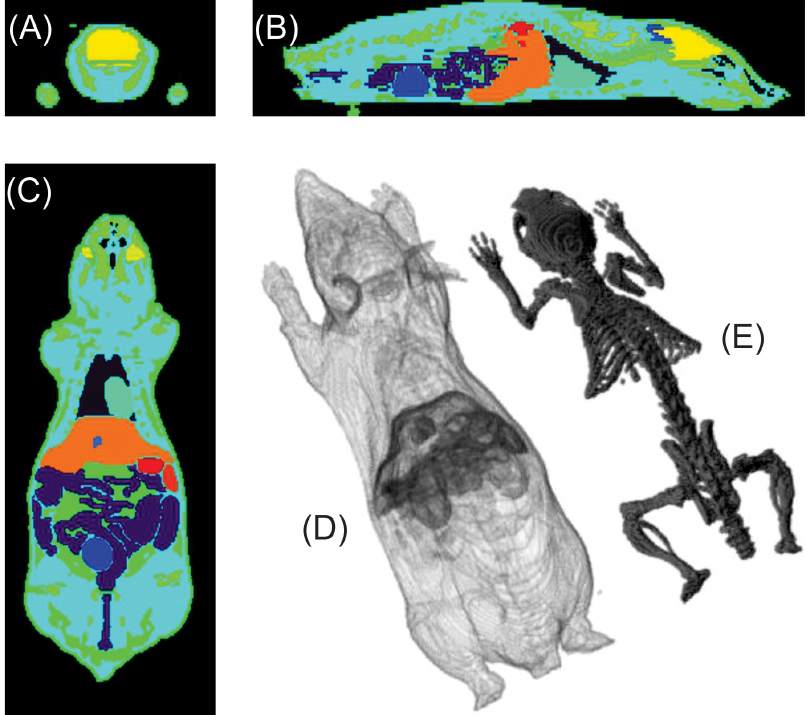
FIGURE 1 - Graphical representations of DM_BRA model obtained through the AMIDE ® software. Coronal (A) Sagittal (B) and transversal (C) slices. Whole body (D) and skeleton (E) 3D